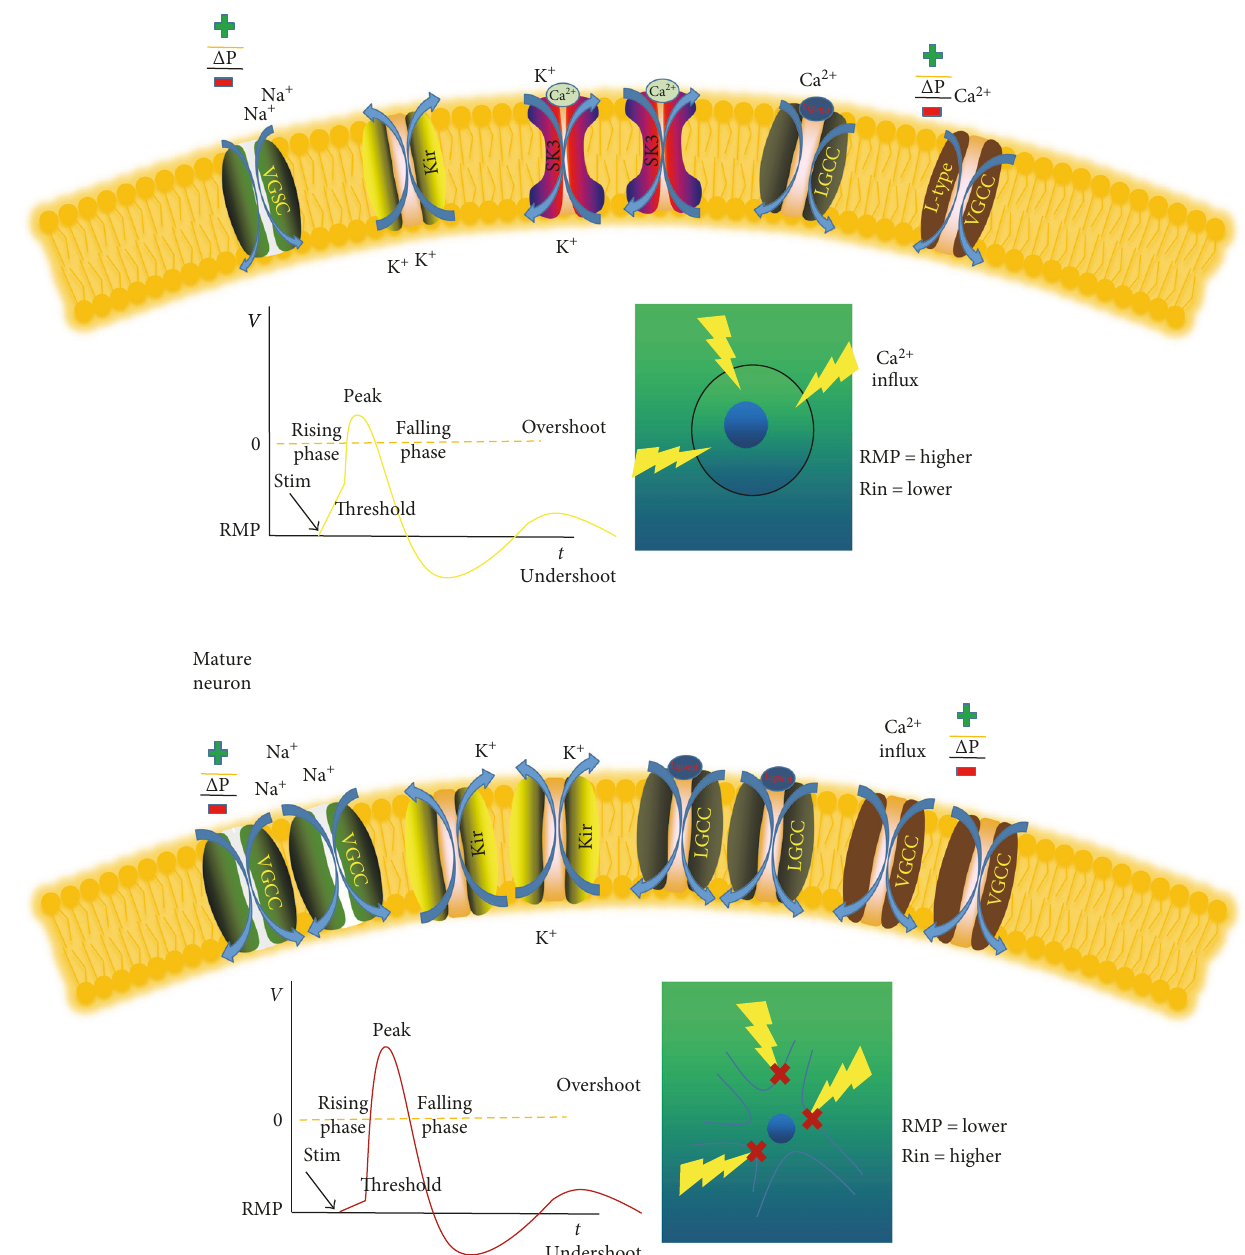
Figure 1: The electrophysiological di ff erences between NSCs and neurons. Compared to mature functional neurons, NSCs exhibit a higher RMP and a lower Rin due to shortage of Kir; moreover, it is not easy for NSCs to generate AP because of a lack of VGSCs. VGCCs, mostly functional L-type and LGCC, are probably the main roles in modulating intracellular Ca 2+ concentration especially L-type VGCCs, Ca 2+ -dependent K + channel SK3 abundantly expressed in NSCs is responsible for the migration and